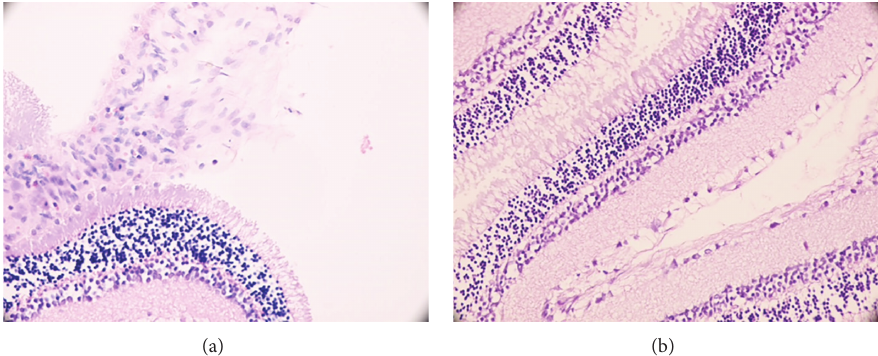
Figure 6: In histopathological section (H&E, × 400) of an eye from (a) one of group 3 rats (saline injected) at 24thh, see moderate retinal infiltration and some retinal folds and from (b) one of group 5 rats (eritoran injected) at 24thh, see minimal infiltrating